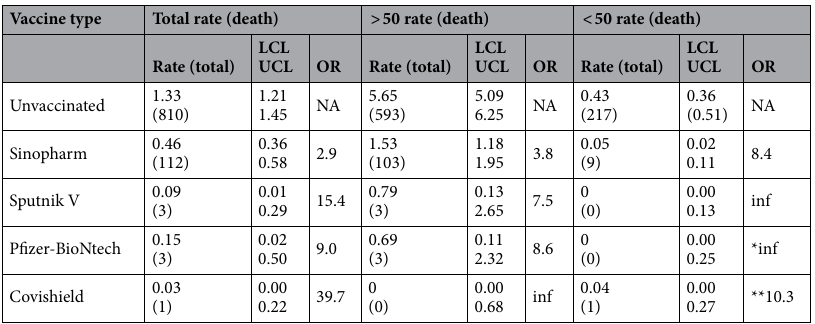
Table 4. Deaths (%) of all SARS-Cov2 positive cases (18 + Ages) after Jan 30th. Death rates% as percentages of PCR positive cases in populations broken down by vaccine type, and age > 50 and < 50 over the time period of final dose were included. UCL refers to Upper Confidence Limit while LCL refers to Lower Confidence Limit. *P-value is 0.029. ** P-value is 0.0019. All other p-values are < 0.001 in pairwise comparisons to unvaccinated individuals.